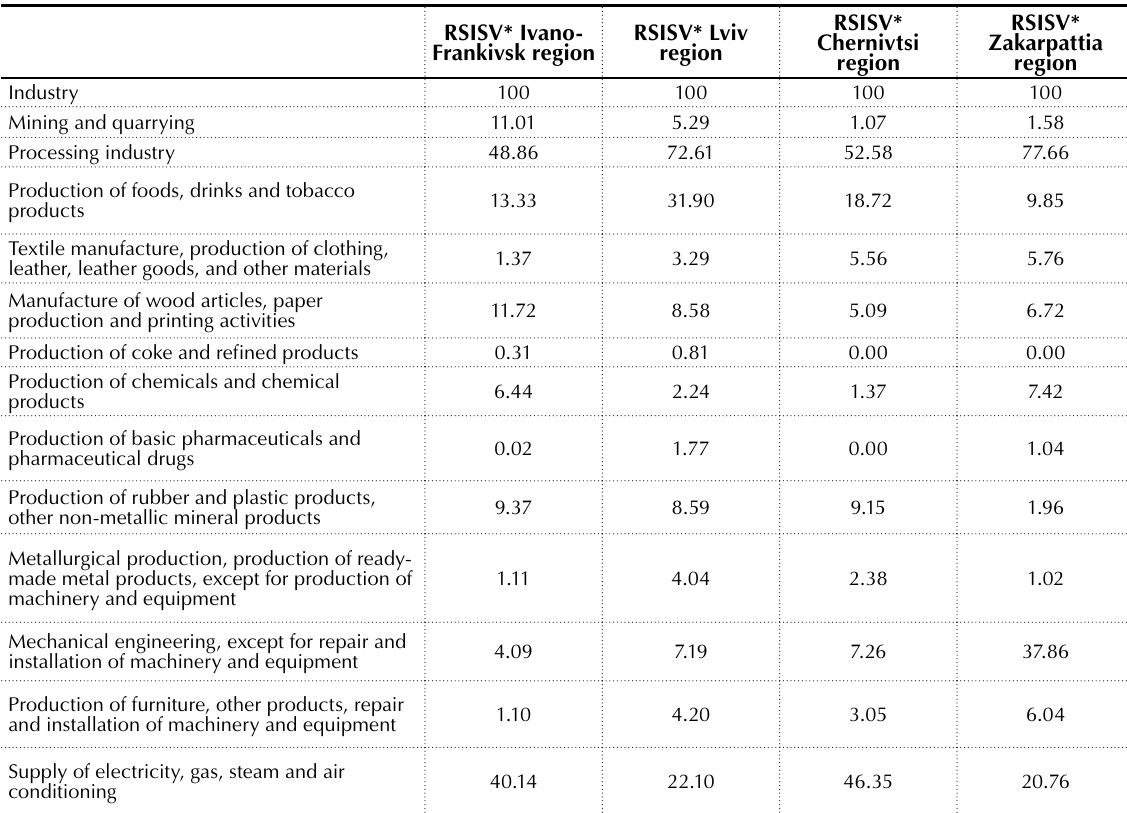
Table 2. Growth areas of the Carpathian economic region are identified as having the highest performance in terms of relative share of the industrial sales volumes (goods, services) by business profile, percent Source: developed by author on the basis of review of the information